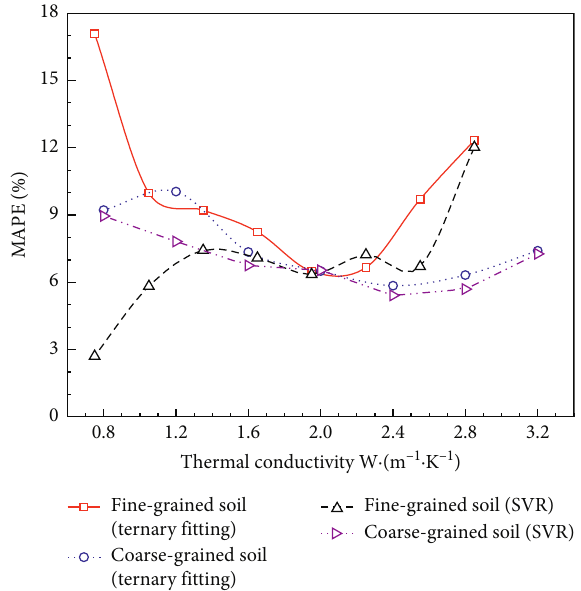
Figure 10: MAPE distribution of ternary fitting and SVR models for coarse- and fine-grained soil categories.